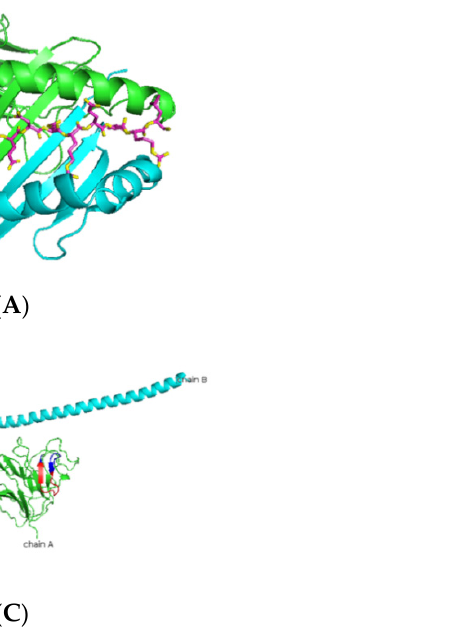
Figure 1. Predicted Ro52 peptide binders docked on HLA-DRB1*0103. ( A , B ) Based on the prediction by SMM-align (stabilization matrix alignment) using IEDB, the top two peptides with IC50 values of 28 and 29 were docked onto the crystal structure of HLA-DRB1*0103 PDB structure 1A6A, and the most optimum predicted position of docking is indicated for both peptides-NPWLILSEDRRQVRL and ANPWLILSEDRRQVR with the core sequence of LSEDRRQVR and LILSEDRRQ, respectively. ( C , D ) The highlighted region indicates the presence of the peptides in the three-dimensional structure of the Ro52 protein.